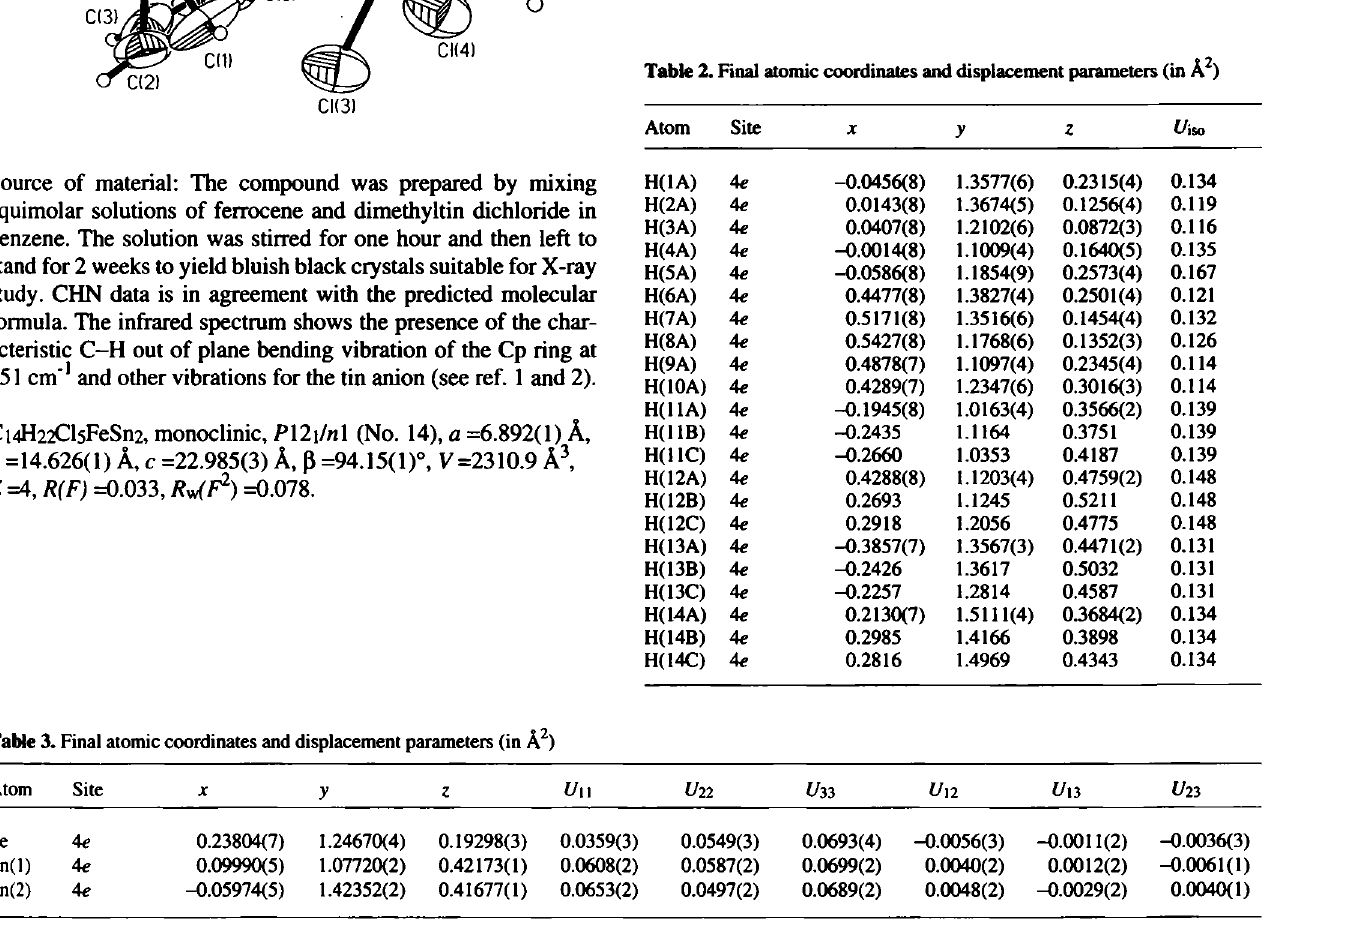
Table 1. Parameters used for the X-ray data collection